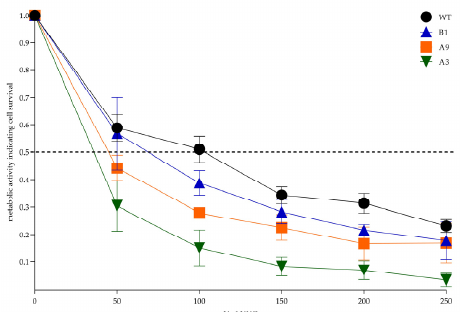
Figure 6. Post-UVC metabolic activity indicating cell survival. In the MTT assay all CRISPR/Cas9- generated subclones were more sensitive to the different UVC doses than the parental A375 XPA WT cells, reflected by a steeper gradient of the descending metabolic activity curves. Statistically significant differences between WT and the generated subclones were observed for A3 cells at doses of 100 J/m 2 and 200 J/m 2 ( p = 0.03 and p = 0.04, respectively; one-way-ANOVA). A p -value < 0.05 was regarded as statistically significant. The dotted line represents the LD 50 . The mean values ± SEM of 3 independent experiments are depicted. LD 50 , lethal dose, 50%; MTT, 3-(4,5-dimethylthiazol- 2-yl)-2,5-diphenyltetrazolium bromide tetrazolium; WT,